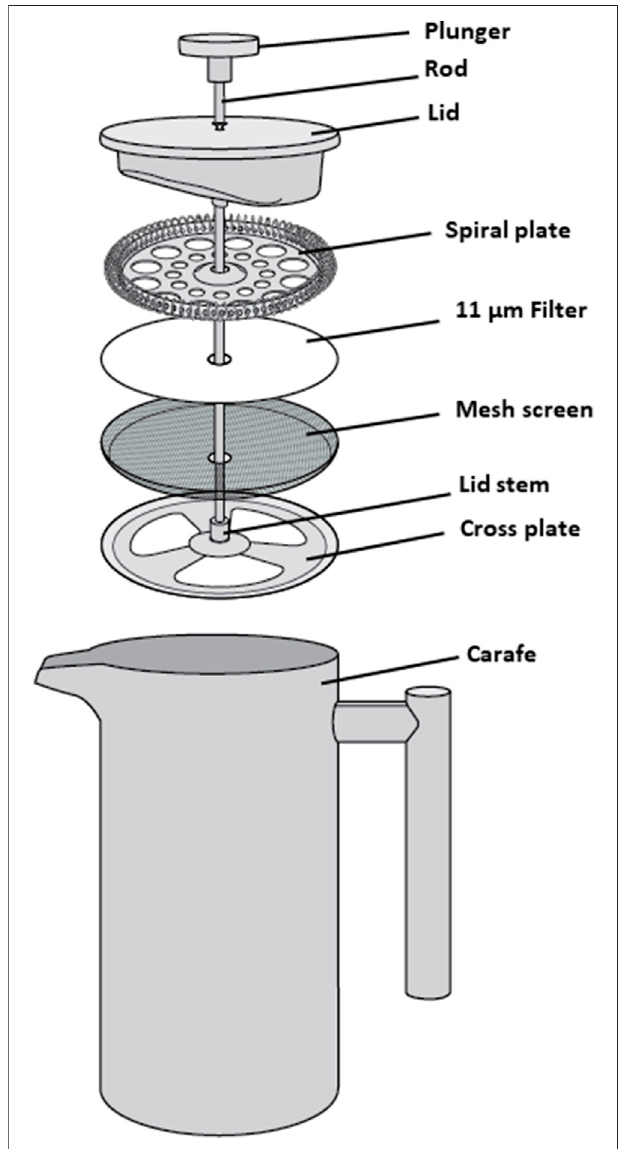
FIGURE 2 | Schematic assembly of a 1 L stainless-steel coffee press, used to press wastewater